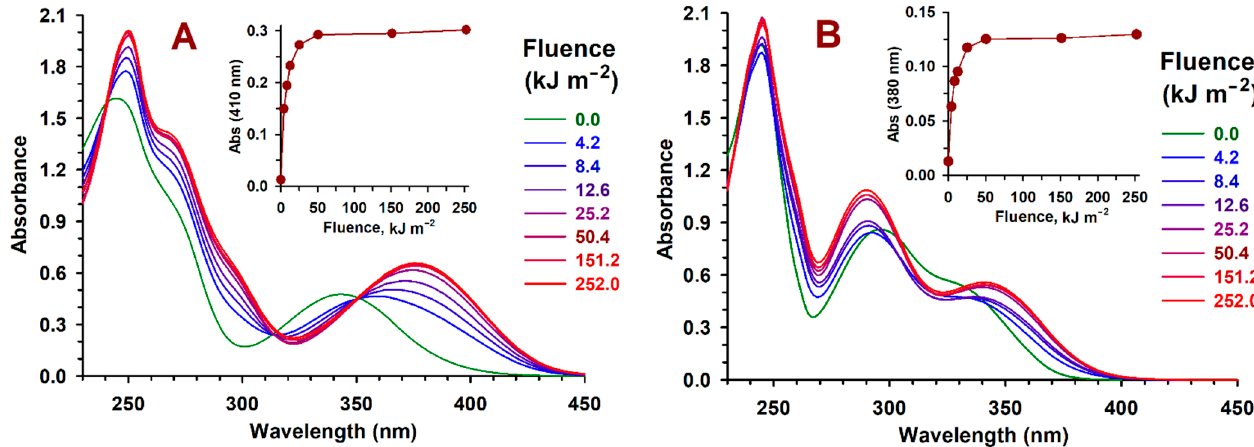
Figure 3. UV-vis absorption changes upon Z → E photoisomerization process. Conditions: ( A ) spectral changes immediately after irradiation of the alkaline solution of psoralen (0.1 mM, 1% of ethanol, pH 13.1) with increasing fluences of UVA irradiation (365 nm, 0–252 kJ m − 2 ). The insert shows the photometric changes at 410 nm; ( B ) spectral changes after strong acidification of the irradiated samples to pH 2. The insert shows the photometric changes at 380 nm. Spectral changes after acidification of the irradiated samples to pH 2 were less prom- inent (Figure 3B). The absorption spectrum of acidified non-irradiated solution coincided with the psoralen absorption spectrum (Figure 1), closely corresponding to HPLC analysis data (Figure S1). At low fluences (4.2–12.6 kJ m − 2 ), the acidified irradiated solutions consist of the newly formed product (presumably E -FCA) and psoralen, the latter being the prod- uct of the pyrone ring back-closure of non-isomerized Z -FCA. Thus, upon an increase in